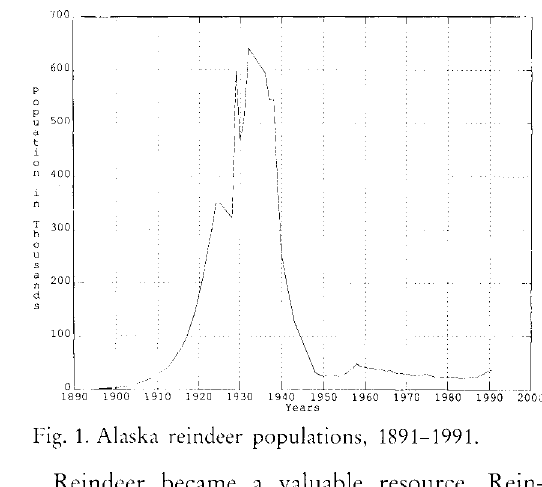
Fig. 1. Alaska reindeer populations,